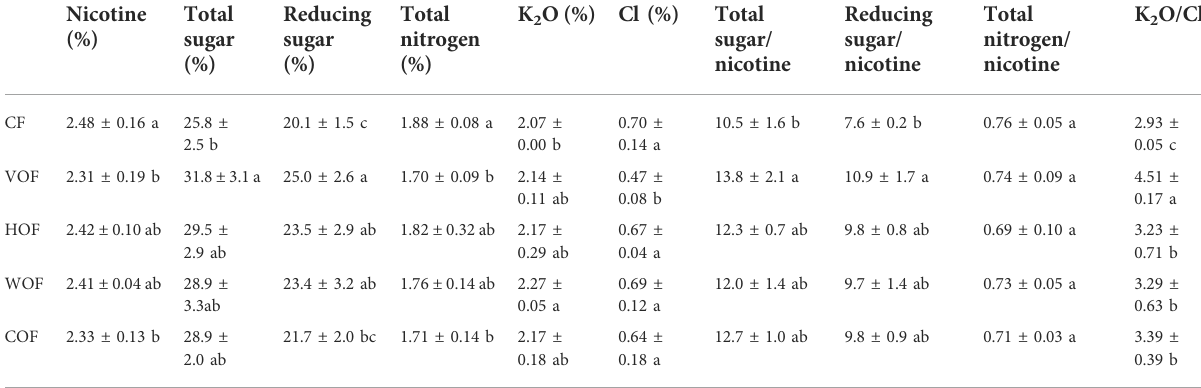
TABLE 1 Tobacco leaf quality parameters (mean ± SD). CF, VOF, HOF, WOF, and COF represent the treatments of tobacco-special chemical fertilizer, vermicompost-based, humic acid-based, wood biochar-based, and compound functional organic fertilizers, respectively. Different letters show a signi fi cant difference within each column based on Duncan ’ s method ( p < 0.05).